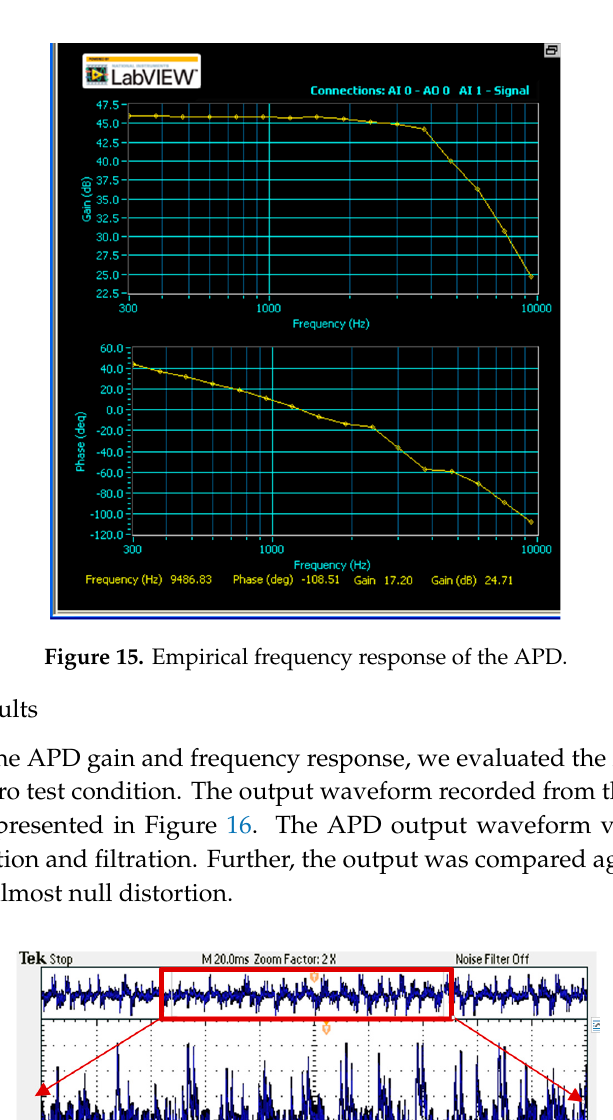
Figure 16. APD output during in vitro validation.